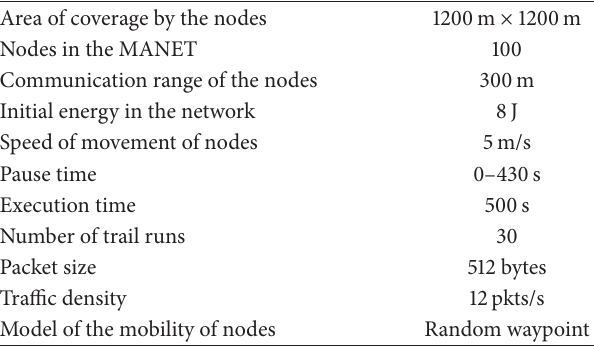
Table 1: Test data for the randomly generated network.